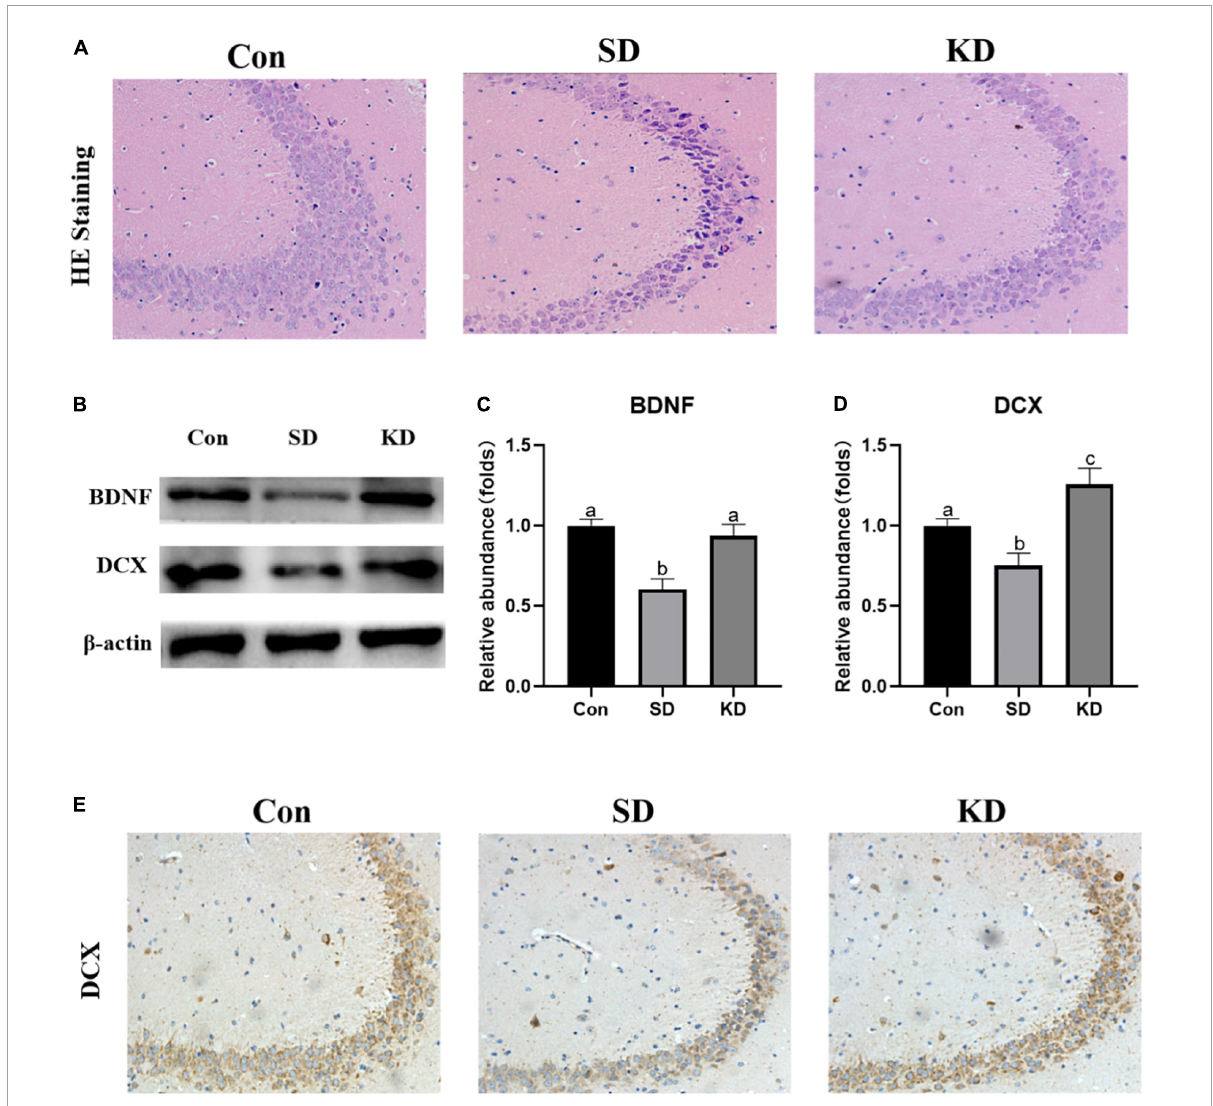
FIGURE4 Effects of ketogenic diet (KD) on the hippocampal damage in the chronic sleep deprivation (SD) exposed mice. (A) H&E staining images of the hippocampus, scale bars = 50 µ m ( n = 3). (B) Western-blots and (C,D) densitometry of BDNF and DCX. Protein levels are normalized to β -actin which served as loading control and reproduced with Sham group. Values are indicated as the mean ± SEM ( n = 7). Different letter indicates significantly different between each group ( p < 0.05). (E) Immunohistochemistry analysis of DCX, scale bars = 50 µ m ( n =